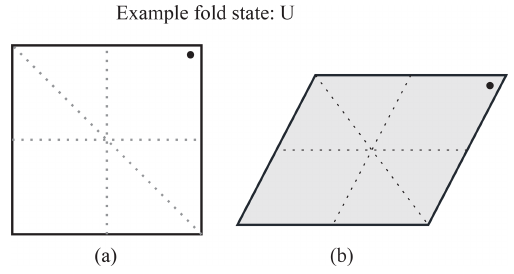
Figure 9. A crease pattern (a) with fold-angle assignment that will result in an unfolded fold state (b) . The legend for fold-angle as- signment is given in Fig. 8. Although the crease pattern appear the same as the fold state, the crease pattern is a planar embedding of the fold state.